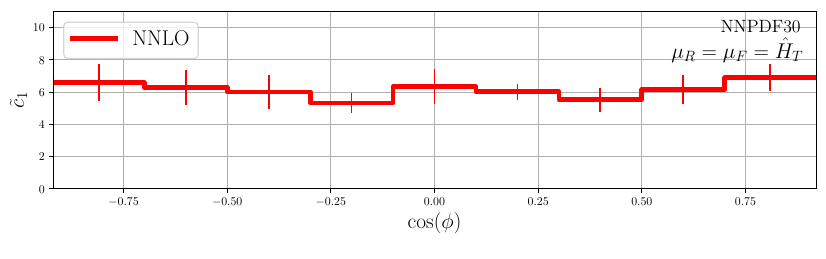
Figure 8 . As in figure 7 but for the